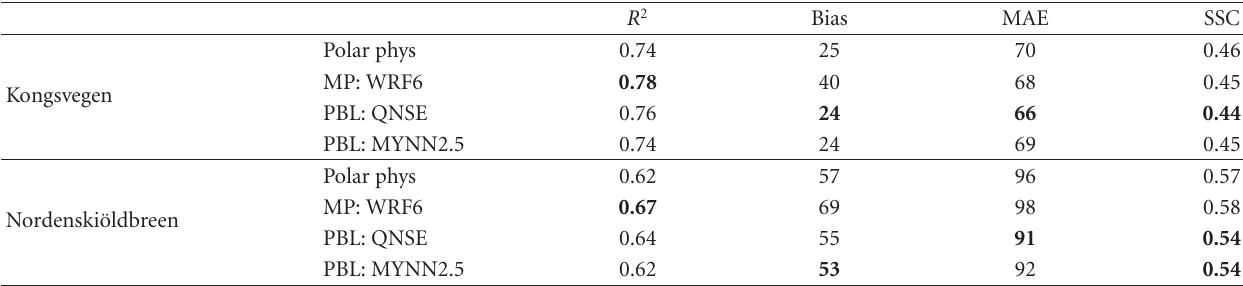
Table 11: Short-wave radiation in summer and in 2.7 km resolution. Bold numbers indicate the best result for each AWS. Vestfonna data are not used here because of the lack of data during the chosen period.